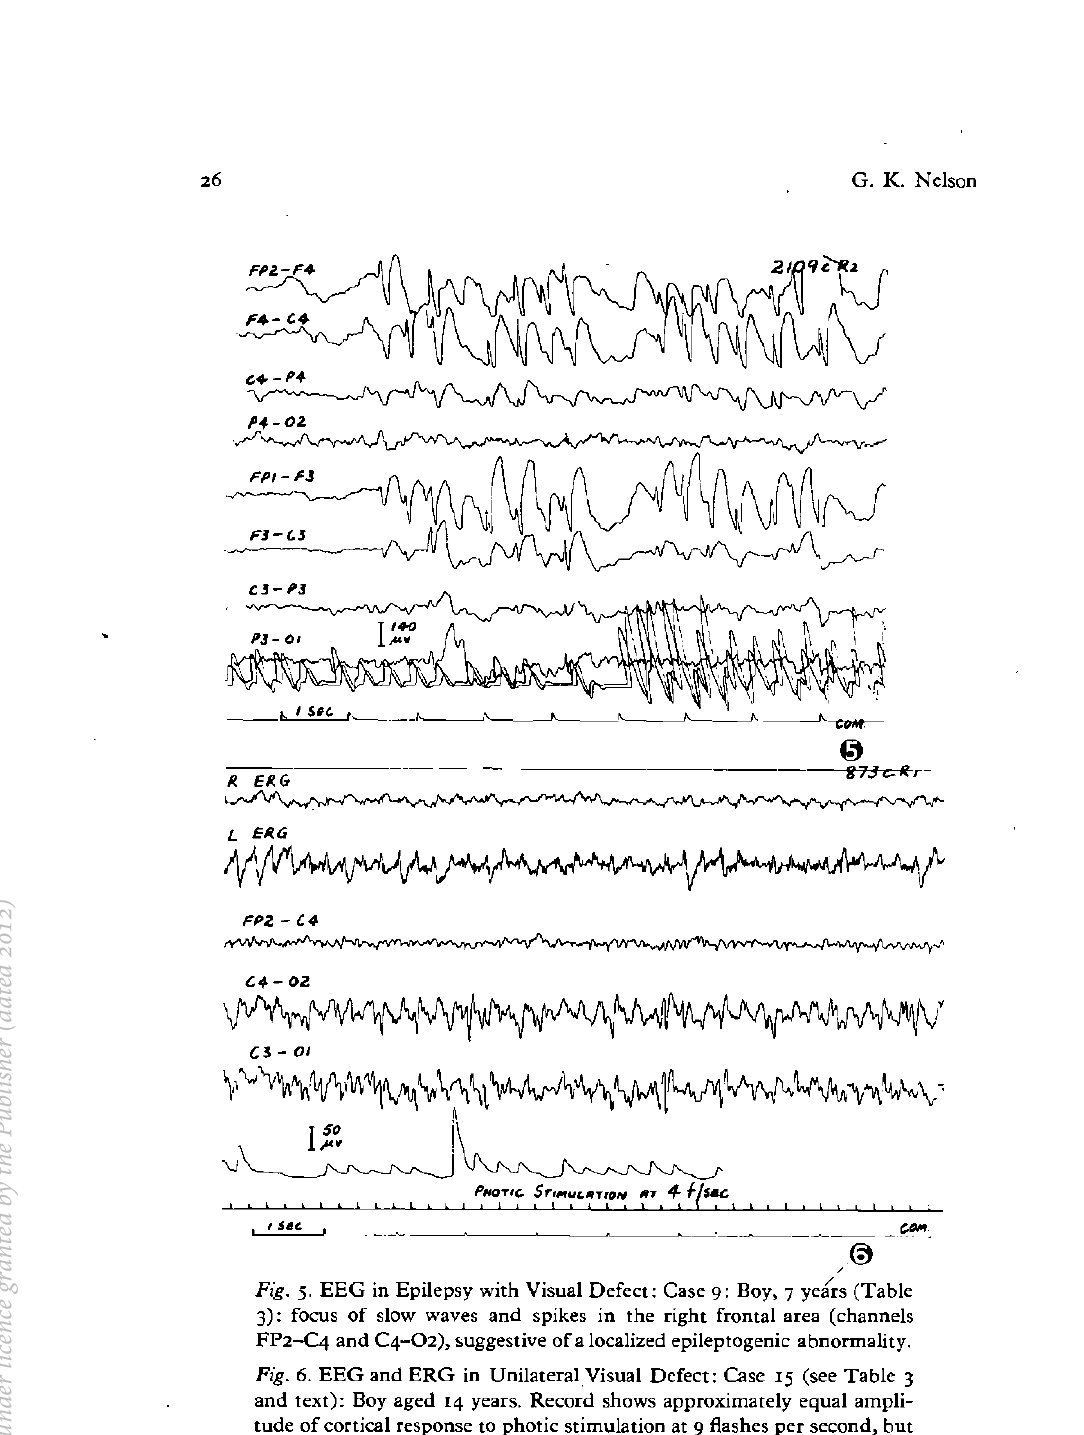
Fig. 5. EEG in Epilepsy with Visual Defect: Case 9: Boy, 7 years (Table 3): focus of slow waves and spikes in the right frontal area (channels FP2-C4 and C4-O2), suggestive of a localized epileptogenic abnormality. Fig. 6. EEG and ERG in Unilateral Visual Defect: Case 15 (see Table 3 and text): Boy aged 14 years. Record shows approximately equal ampli- tude of cortical response to photic stimulation at 9 flashes per second, but marked reduction of ERG on right side. Irregular trace above photic stimulation registration is automatic frequency analyzer write-out, show- ing dominant activity at 4 c/sec. in R